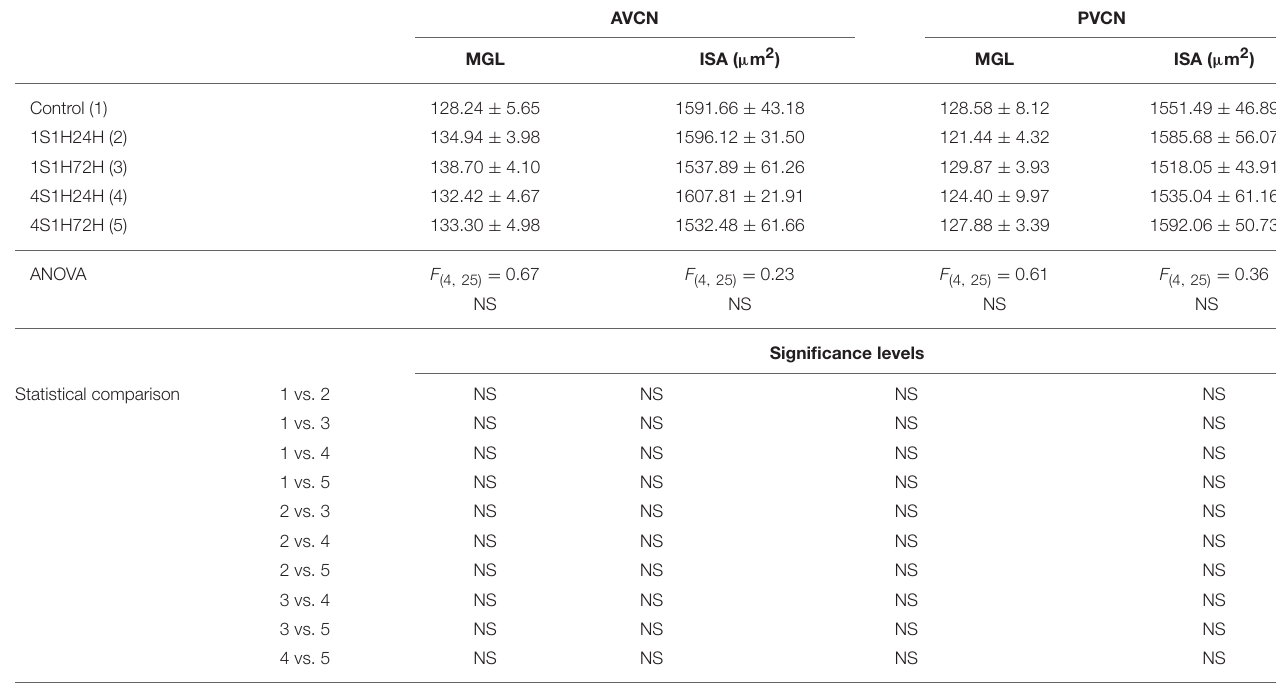
TABLE 9 | Synaptophysin immunostaining in the AVCN and PVCN in control and experimental